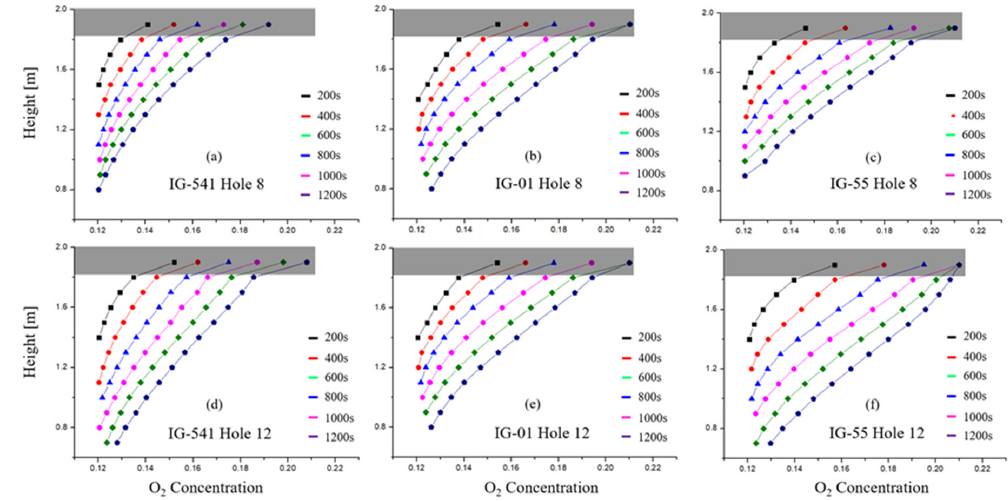
Figure 8. Change in the interface slope 𝛼 over time for each agent (average value of 5 data).